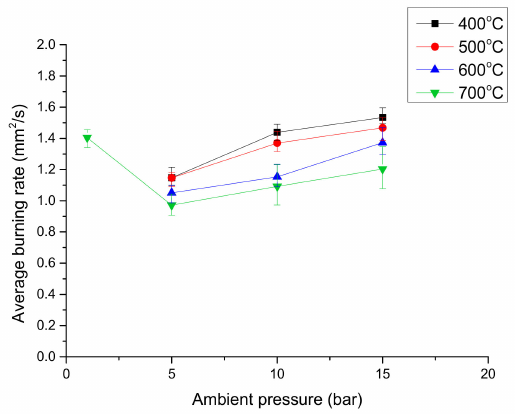
Figure 10. Average burning rate of a diesel droplet at various ambient temperatures and